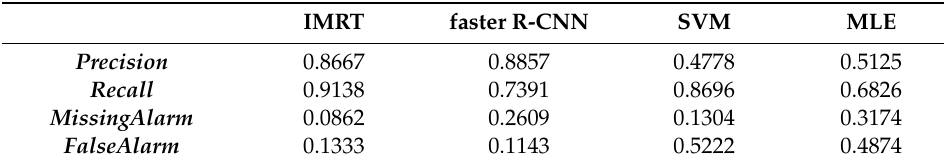
Table 2. Precision evaluation based on objects.